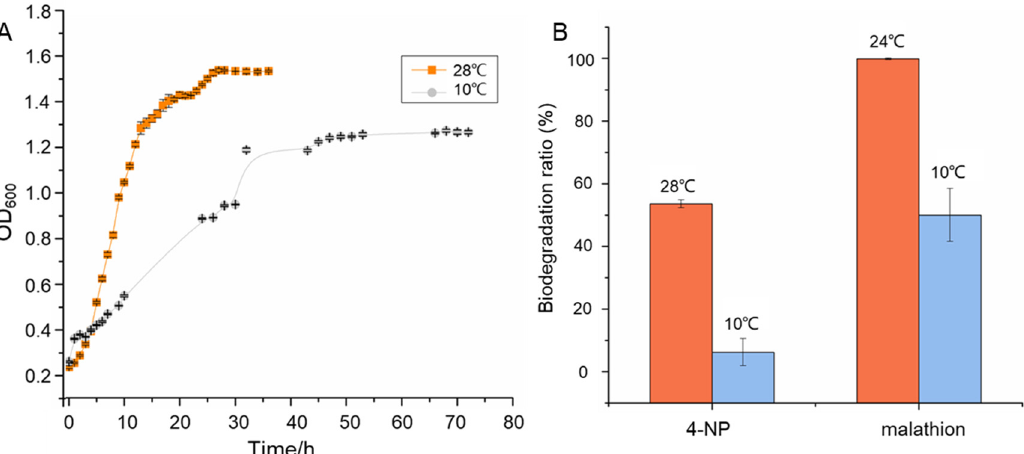
Figure 3. Growth ( A ) and biodegradation ability ( B ) of R. tibetensis FXJ9.536 at different temperatures. Error bars show the mean ± standard deviation of three independent experiments.